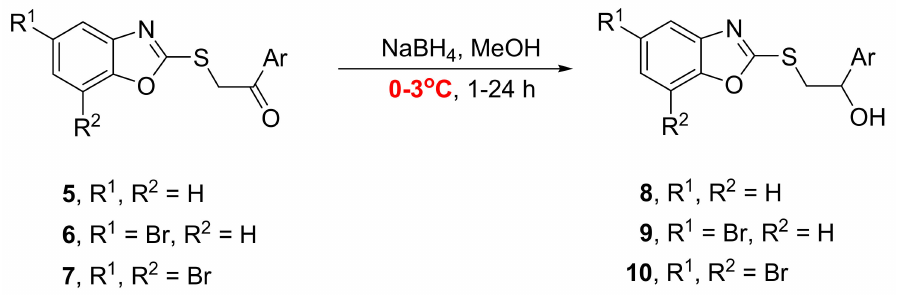
Scheme 2. Synthesis of alcohols 8 by reduction in ketones